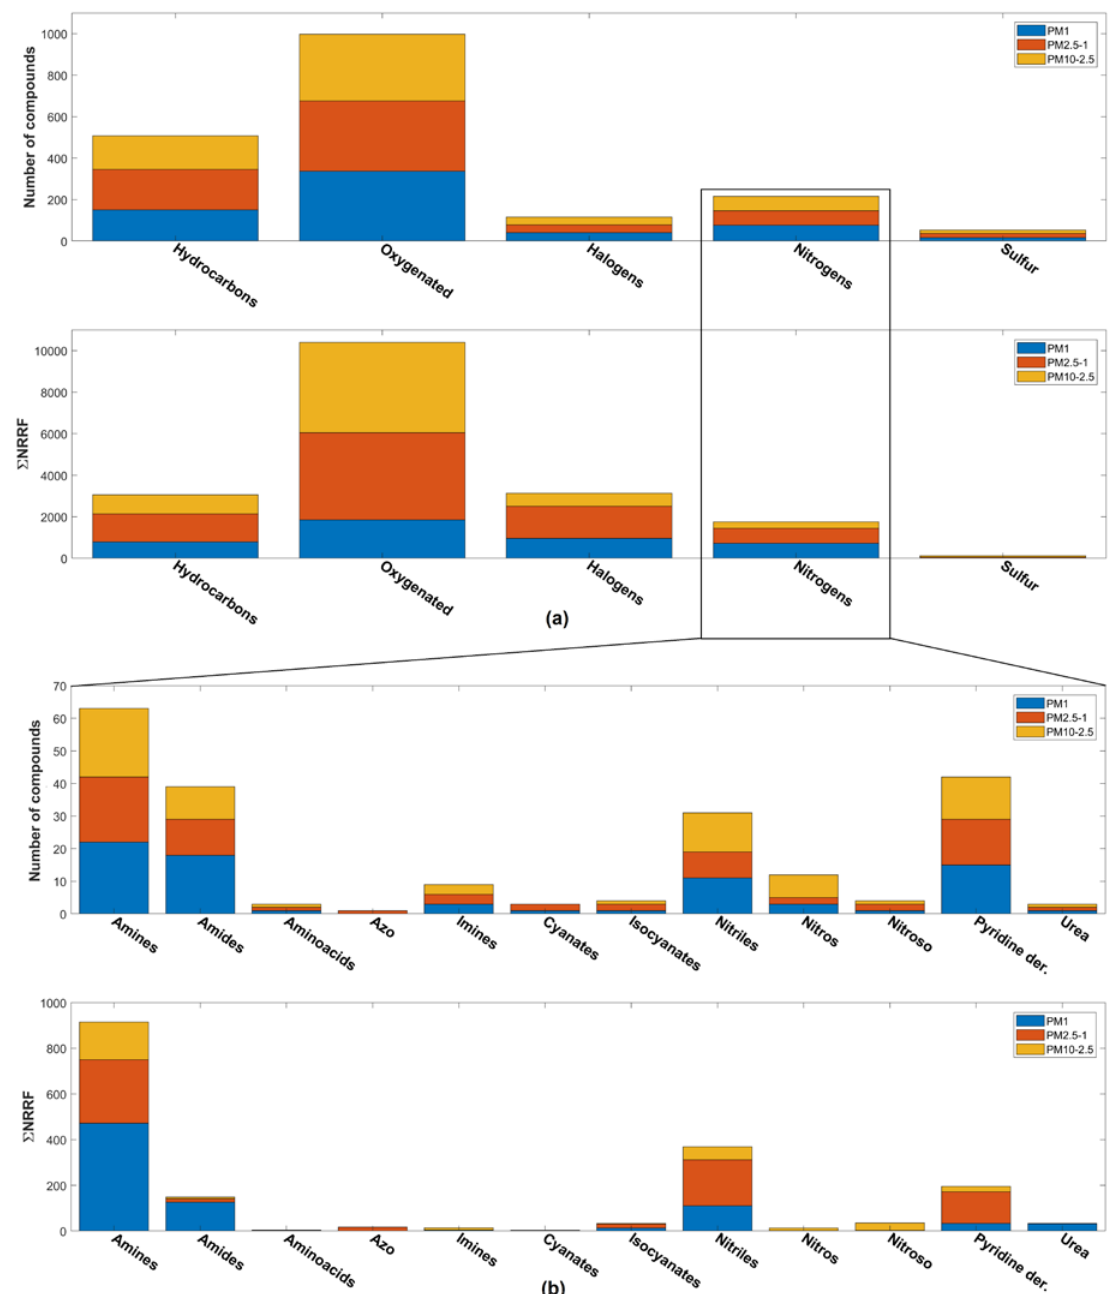
Figure 1. ( a,b ) Contextualisation of nitrogen-containing functional groups in relation to the total number of compounds tentatively identified with their associated normalised relative response factors ( Σ NRRFs) of di ff erent organic (N) compounds for each of the functional group categories in the three particle size ranges (adapted from Figures 4 and 8 in Booyens et al. [29]).